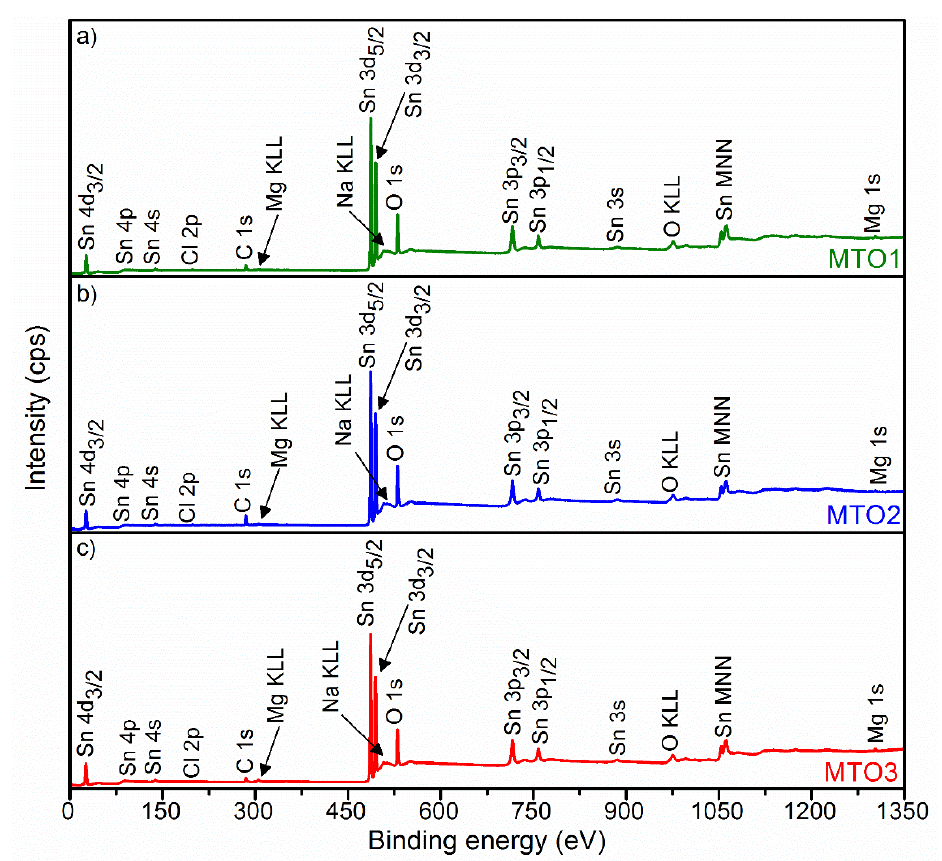
Figure 4. XPS survey spectra of the Mg-doped SnO 2 thin films, ( a ) MTO1; ( b ) MTO2; ( c ) MTO3.